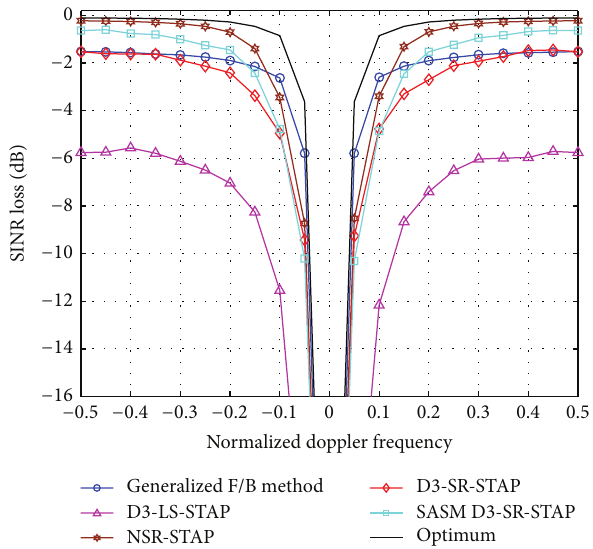
Figure 4: SINR loss against the target Doppler frequency in homo- geneous environments.